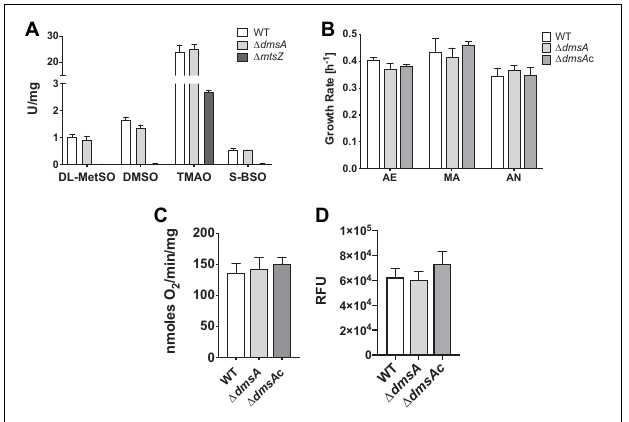
FIGURE 2 | Comparison of in vitro physiological properties of Hi2019 WT and Hi2019 (cid:49) dmsA . (A) S- and N-oxide reductase activities in Hi2019 (cid:49) dmsA and Hi2019 (cid:49) mtsZ strains using known S- and N-oxide reductase substrates: DL-MetSO – DL-methionine sulfoxide; DMSO – dimethylsulfoxide, TMAO – trimethylamine N-oxide, S-BSO – S biotin sulfoxide. (B) Growth rate of Hi2019 WT , Hi2019 (cid:49) dmsA , and Hi2019 (cid:49) dmsAc on CDM medium with glucose under aerobic (AE) microaerobic (MA) or anaerobic (AN) conditions. None of the data showed statistically significant differences ( p < 0.05). (C) Oxygen-dependent respiration of Hi2019 WT , Hi2019 (cid:49) dmsA , and Hi2019 (cid:49) dmsAc with glucose as the substrate. (D) Bacterial cell health of Hi2019 WT , Hi2019 (cid:49) dmsA , and Hi2019 (cid:49) dmsAc following growth on CDM glucose medium determined using a BacTiter-Glo assay (Promega). RFU – relative fluorescence units. Statistical analyses (B–D) used one-way ANOVA